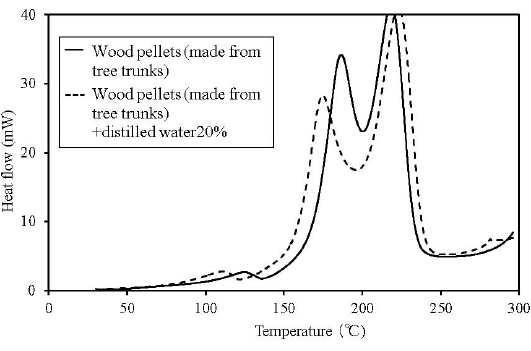
Figure 4. C80 calorimetry curves for wood pellets (made from tree bark).